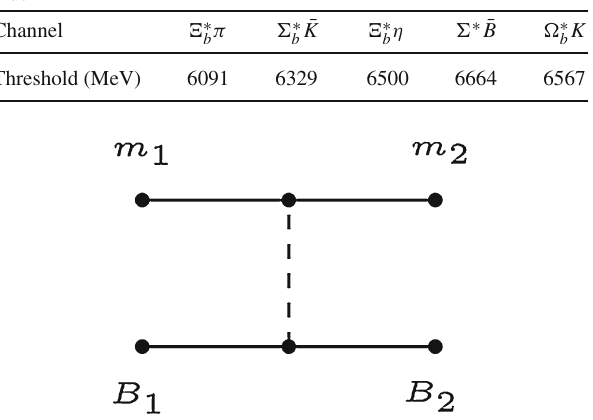
Table6 Beautysectorchannelswith J P = 3 / 2 − andrespectivethresh-